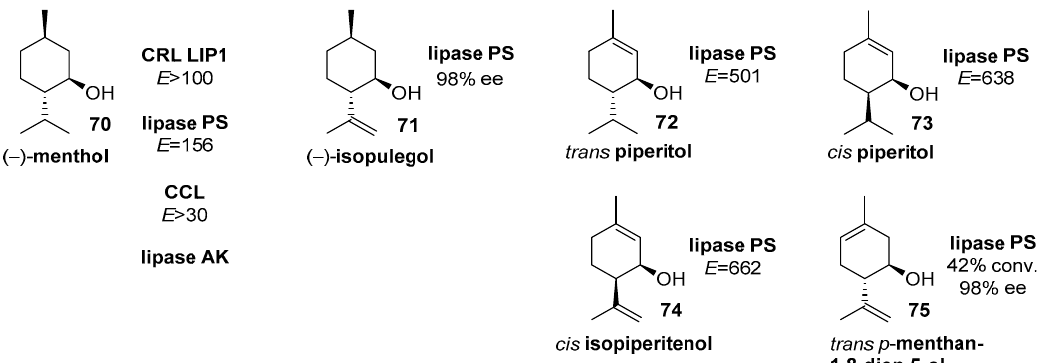
Figure 13. Compounds 70 – 75 are p -menthan-3-ol monoterpenes obtained by lipase-mediated resolution. The lipase used and its stereoselectivity are indicated next to the alcohol.